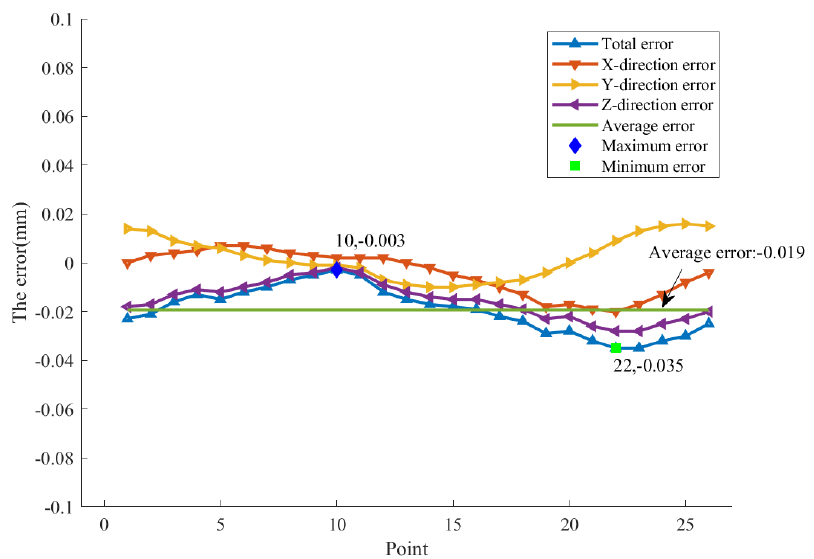
Figure 17. The error distribution of sample points.